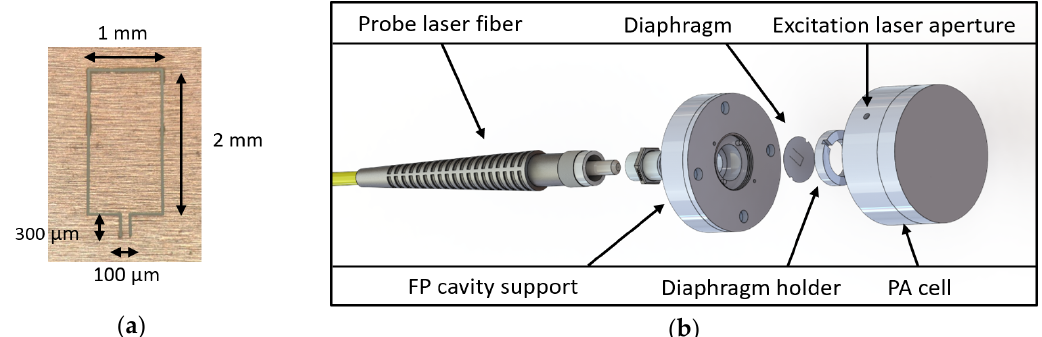
Figure 11. ( a ) Microscope image of the manufactured hinged cantilever; ( b ) 3D view of the fabricated PA sensor with (from left to right) the optical fiber, a threaded adapter, the FP transducer support, the cantilever-based diaphragm, a threaded ring to hold the diaphragm and the cylindrical multipass PA cell.